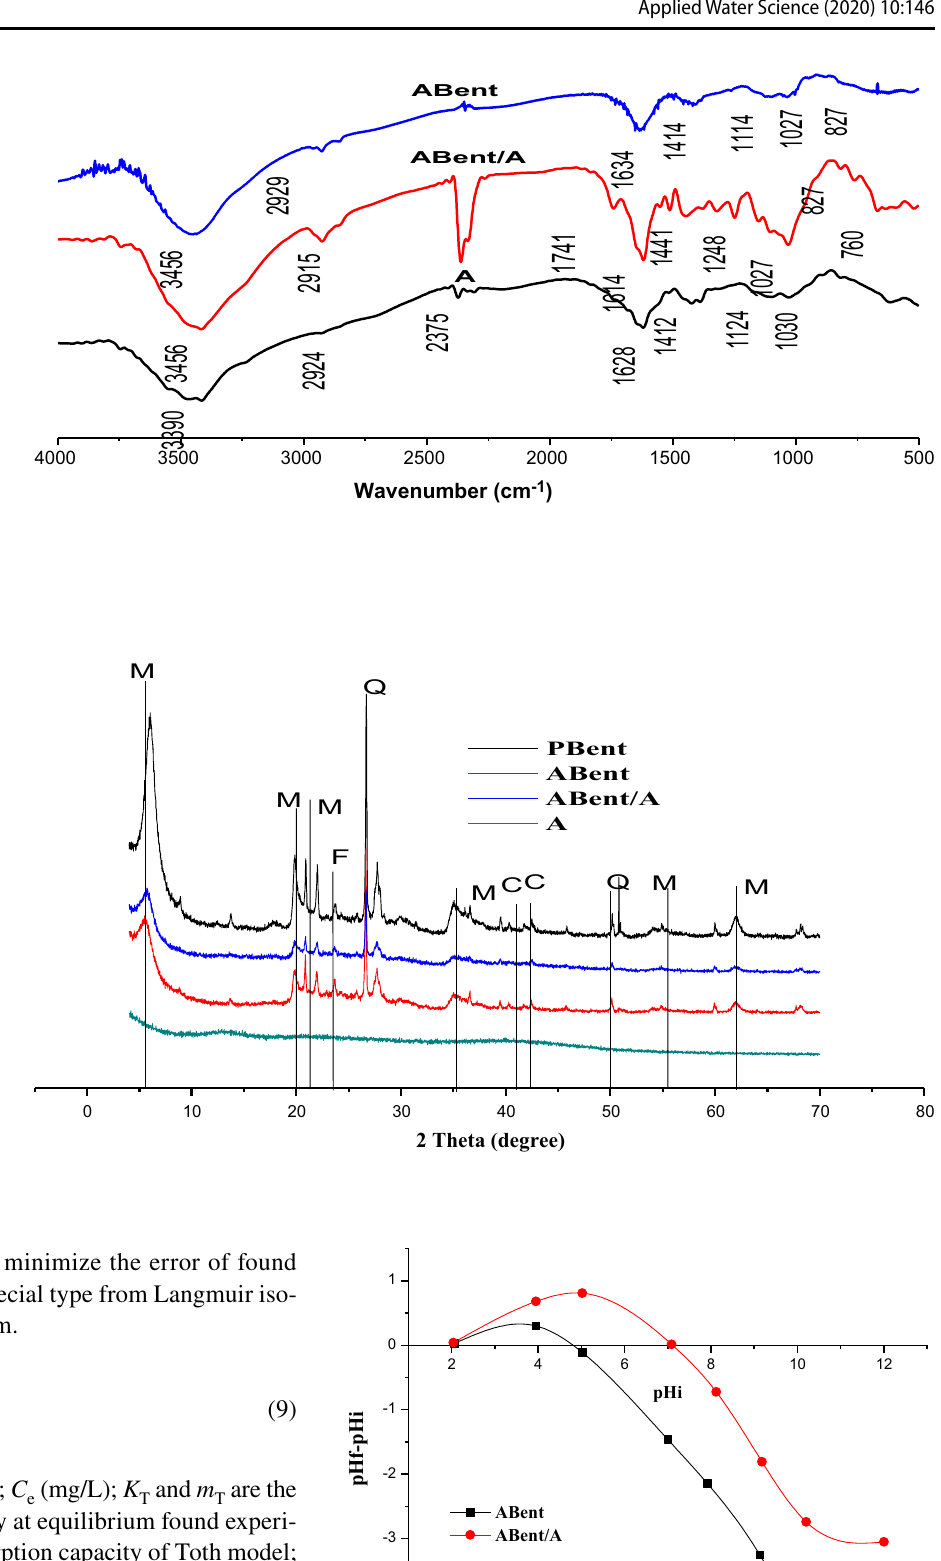
Fig. 2 FTIR spectrum of ABent, A and ABent/A